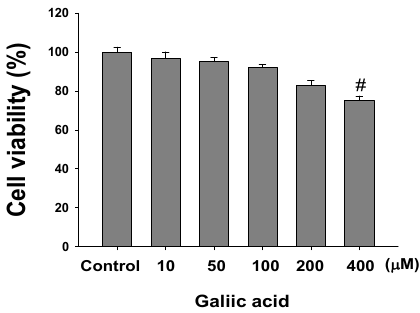
other melanogenesis-related proteins. Figure 1. Effect of gallic acid on the cell viability of B16F10 cells. B16F10 melanoma cells were treated with various concentrations of gallic acid for 24 h, and cell viability was determined by 3-(4,5-cimethylthiazol-2-yl)-2,5-diphenyl tetrazolium bromide (MTT) assay. The data presented are from three independent experiments ( # p < 0.05 compared with the control).